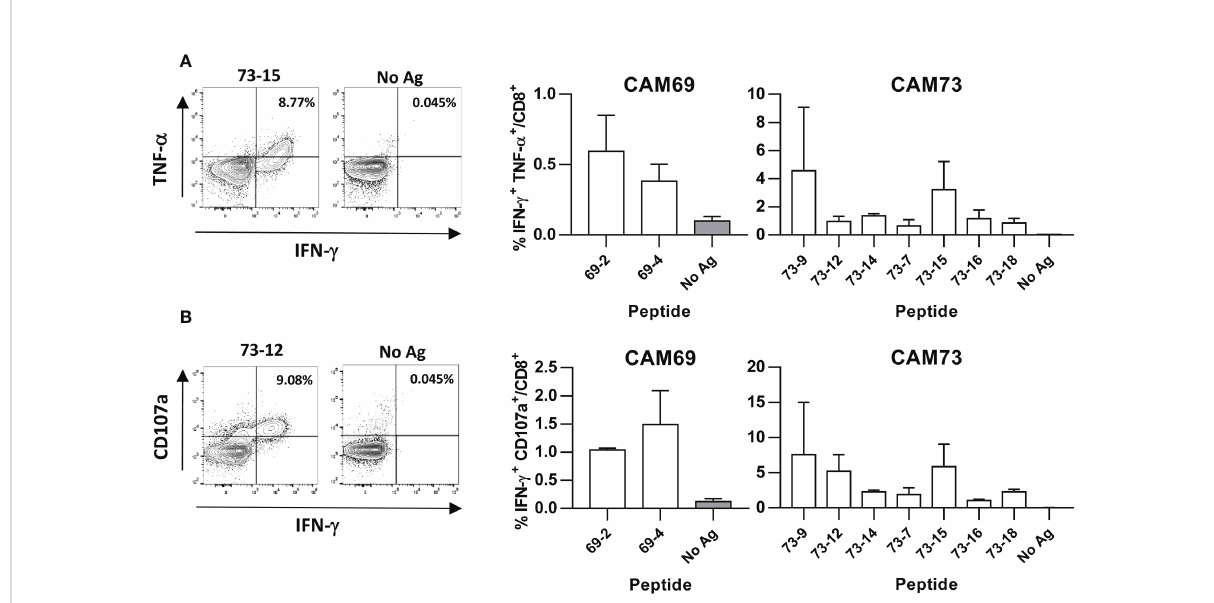
FIGURE 4 Induction of polyfunctional T cell responses by neoantigen vaccines. HHD-DR1 mice (n=3-4/group) were immunized with peptides (100 nanomoles) plus poly(I:C) and antiCD40 adjuvants at days 0 and 7. One week after the boost, they were sacri fi ced and splenocytes were stimulated with or without peptides (10 m M) and response evaluated by fl ow cytometry measuring the percentage of CD8 T cells expressing IFN- g and TNF- a (A) and IFN- g and CD107a (B) . Representative examples of peptide 73-12 and 73-15 (left panels) and summarized results of all peptides (right panels) are